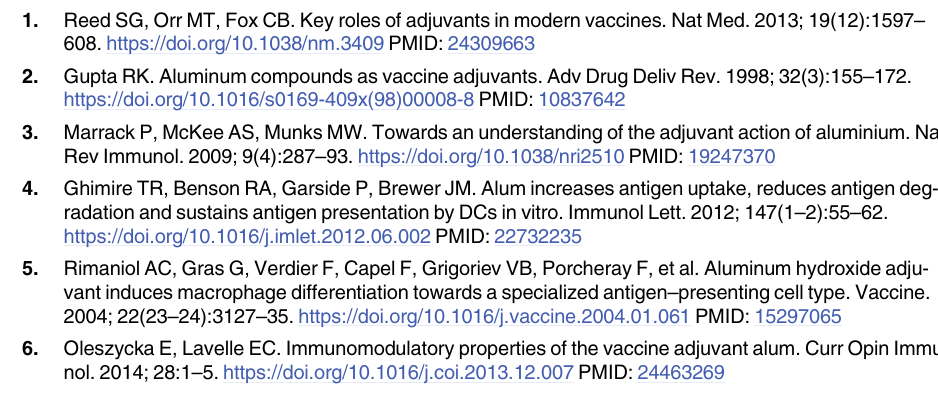
S4 Fig. Evaluation of OX40L expression after intranasal administration of alum. Mice were intranasally administered SV with or without 100 μ g/mouse alum. At 24 h after administra- tion, the lungs were collected to analyze OX40L expression. The OX40L MFI of the total mononuclear cells was determined for each group. The data are from three independent experiments, and error bars are presented as the mean ( ± SEM) of three mice per group. Sig- nificance was assessed using one-way ANOVA and Dunnett’s multiple-comparison test to determine the differences between SA and the other groups. Relative to Fig 6. S5 Fig. Schematic diagram of the immunization studies related to Fig